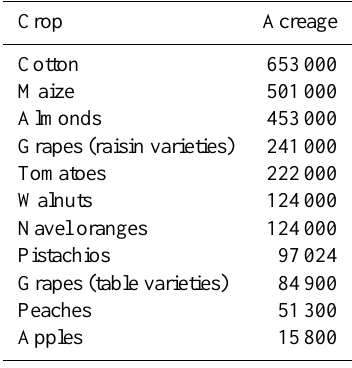
Table 1. Planted areas for permanent crops with largest land cover in the San Joaquin